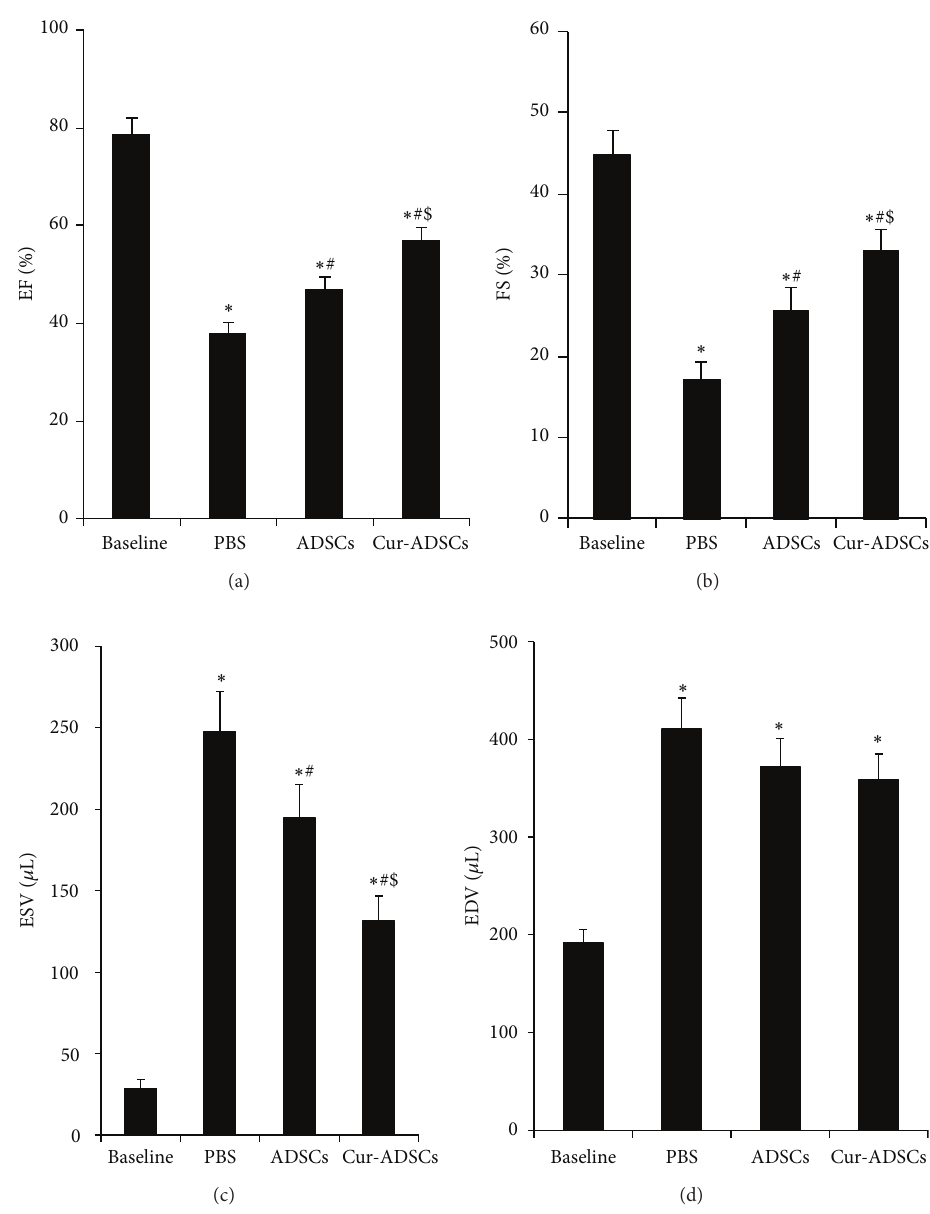
Figure 4: Echocardiographic assessment of cardiac function. ((a)-(b)) EF and FS were highest in the Cur-ADSCs group compared with PBS control and ADSCs groups ( 𝑃 < 0.05 ). (c) ESV was significantly improved in the Cur-ADSCs group compared with PBS control and ADSCs groups ( 𝑃 < 0.05 ). (d) There is no significant difference for EDV among PBS, ADSCs, and Cur-ADSCs groups. Statistical differences ( 𝑃 < 0.05 ) are indicated from the baseline ( ∗ ), PBS (#), and ADSCs